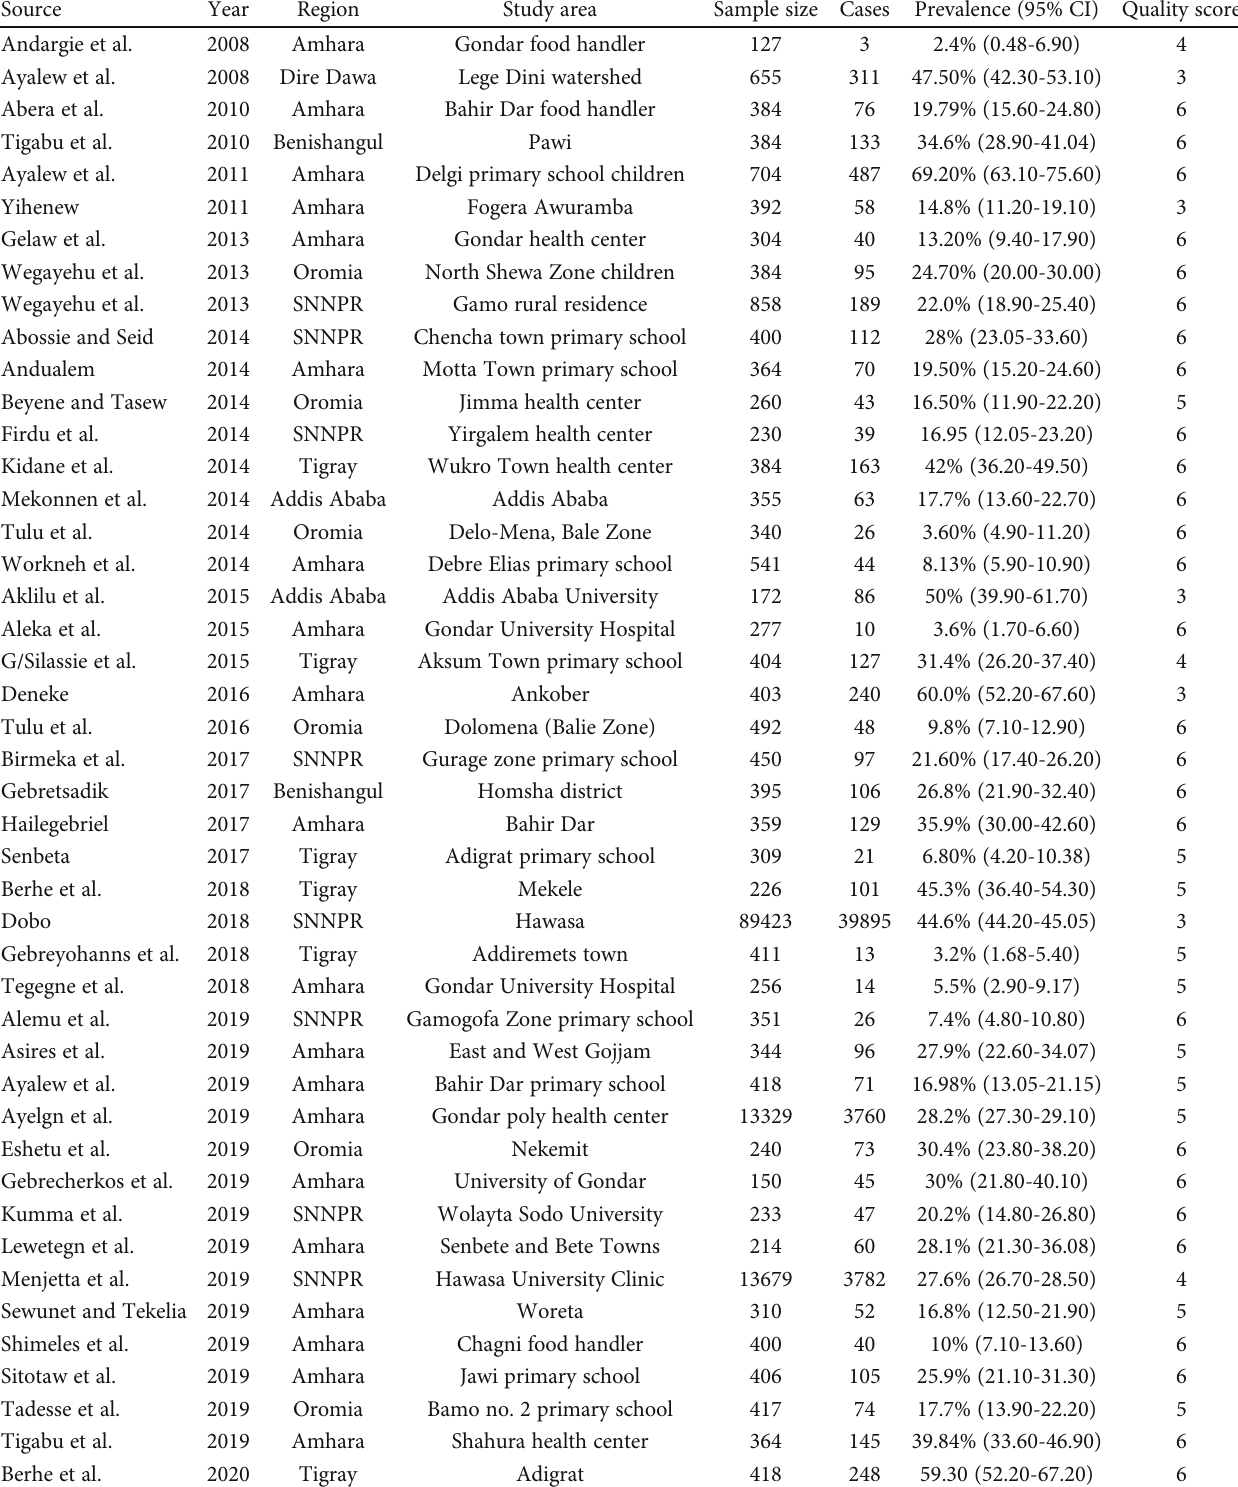
Table 1: Characteristics of the study subjects included in the eligible articles used for this